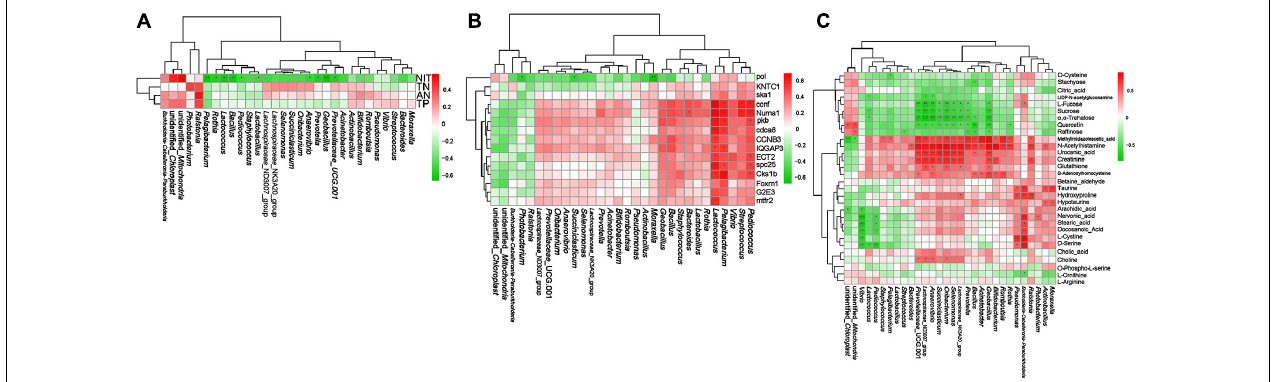
FIGURE 10 | Spearman correlation analysis between distal intestinal bacteria at genus level and water pollutants, DEGs, DMs. The correlation analysis of distal intestinal bacteria and water pollutants (A) . The correlation analysis of distal intestinal bacteria and DEGs (B) . The correlation analysis of distal intestinal bacteria and DMs (C) . Red and green indicate positive and negative correlation, respectively. * significant differences ( P < 0.05), ** very significant differences ( P < 0.01), *** extremely significant differences ( P <